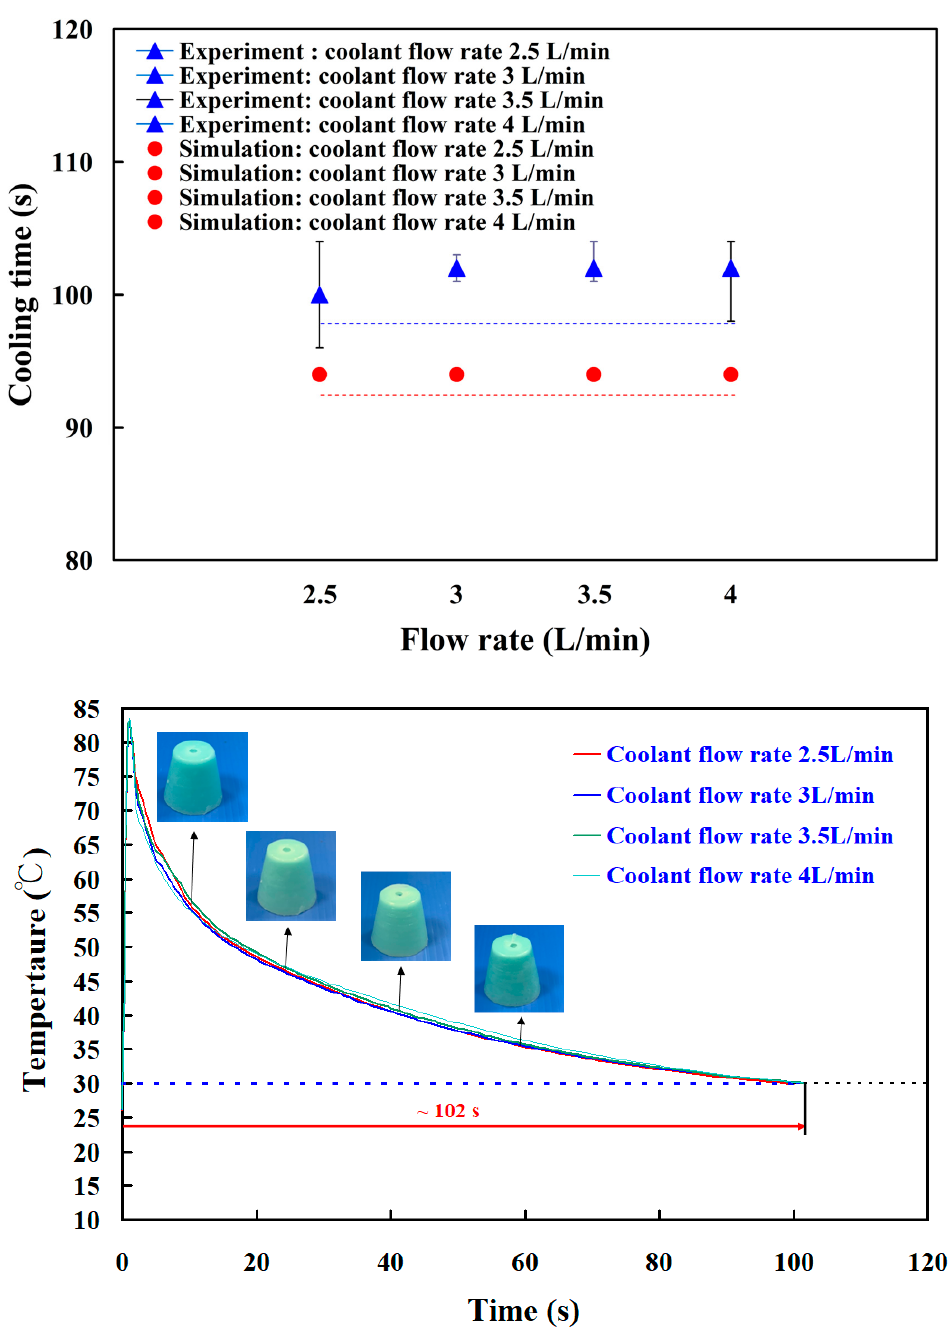
Figure 24. The cooling time of the wax pattern as a function of flow rate. To understand the differences in the cooling time between the numerical simulation and experiment, the actual cooling time was measured by wax injection molding. Figure 25 shows the four different kinds injection molds of material cost and the cooling time of the wax pattern. It is important to note that the material costs of injection molds fabricated with commercial material, epoxy resin added with 41 vol.% Cu powder, epoxy resin added with 39 vol.% Al powder, and epoxy resin added with 37 vol.% Fe powder were